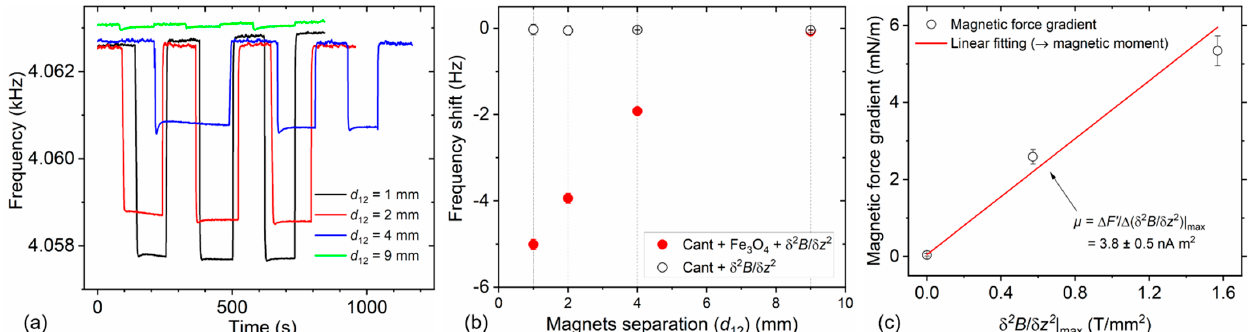
Figure 9. ( a ) Observed frequency responses under various magnetic force gradient conditions (magnets spacing) for a cantilever (S84/CAN30-1-2) attached with magnetic particles (Fe 3 O 4 NPs). The used cantilever had k 0 ≈ 2.85 ± 0.19 N/m and f 0 ≈ 4.148 kHz, and it was excited in an out-of-plane mode (same direction as the induced external magnetic field and second its derivative). ( b ) Average shift in resonant frequency with magnets spacing ( d 12 ) for a blank cantilever (open red circles) and effective resonant frequency shifts (filled red circles). ( c ) Magnetic force gradient F (cid:48) (Equation (16)) versus the maximum second derivative magnetic field gradient (determined by FEMM). The linear fitting in (c) was performed for d 12 = 2 mm to 9 mm; its slope was equivalent to the particles’ magnetic moment ( → Equation (7)). The values of the polarizing field and its second derivative depended strongly on the positioning accuracy of the cantilever, which had to be performed against the risk of breaking the cantilever. Consequently, since positioning at δ 2 B / δ z 2 | max was much more difficult at decreased spacing, a deviation from linearity was observed.